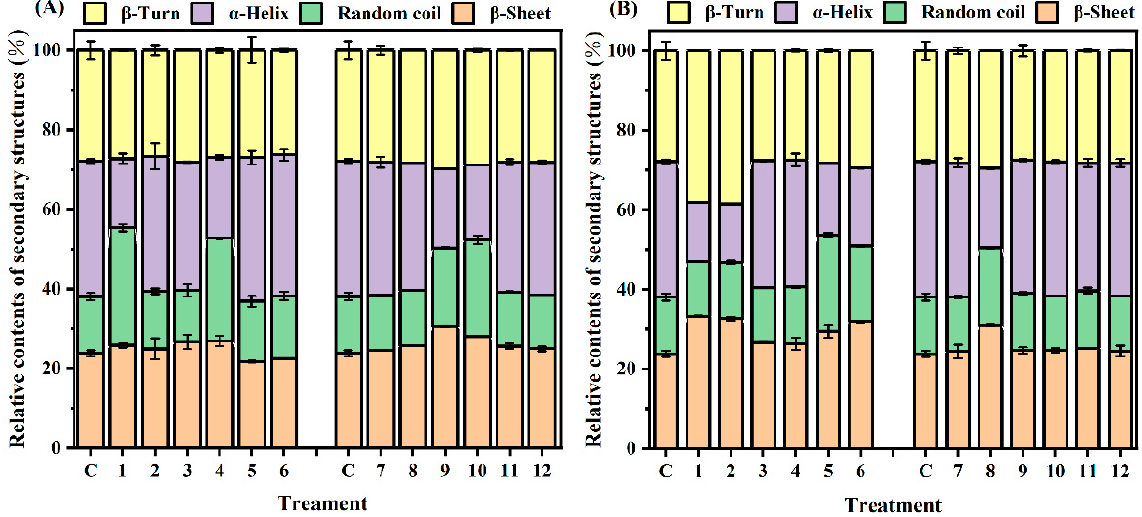
Figure 7. Changes in relative contents of secondary structures of myofibrillar protein and glucose (MPG) and myofibrillar protein (MP) heated at 80 °C ( A ) and 98 °C ( B ) for 0 − 45 min. c = 0 min; 1 = MP, 2.5 min; 2 = MP, 5 min; 3 = MP, 10 min; 4 = MP, 15 min; 5 = MP, 30 min; 6 = MP, 45 min; 7 = MPG, 2.5 min; 8 = MPG, 5 min; 9 = MPG, 10 min; 10 = MPG, 15 min; 11 = MPG, 30 min; 12 = MPG, 45 min.